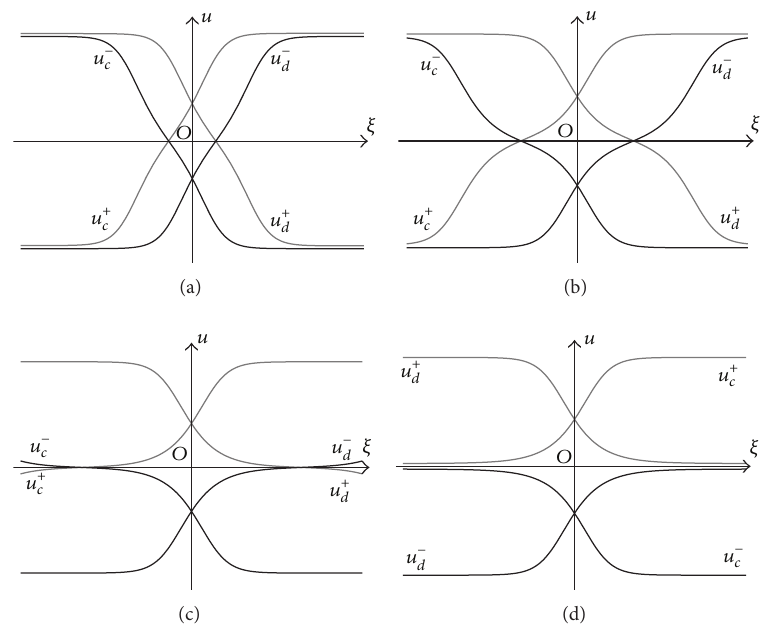
Figure 4: Four low-kink waves are bifurcated from four tall-kink waves. The varying process for the figures of 𝑢 ± 𝑐 and 𝑢 ± 𝑑 when 𝜂 > 0 , 𝜂 ̸=|𝜇 0 | , 𝑏 → −(5𝑎 2 /48𝑐) + 0 , where 𝜂 = 10 , 𝛿 = 𝛾 = 𝑐 = 𝑎 = 1 , and (a) 𝑏 = −(5𝑎 2 /48𝑐) + 10 −2 , (b) 𝑏 = −(5𝑎 2 /48𝑐) + 10 −3 , (𝑎,𝑏) ∈ 𝐴 2 , and (c) 𝑏 = −(5𝑎 2 /48𝑐) + 10 −5 , and (d) 𝑏 = −(5𝑎 2 /48𝑐) + 10 −7 .